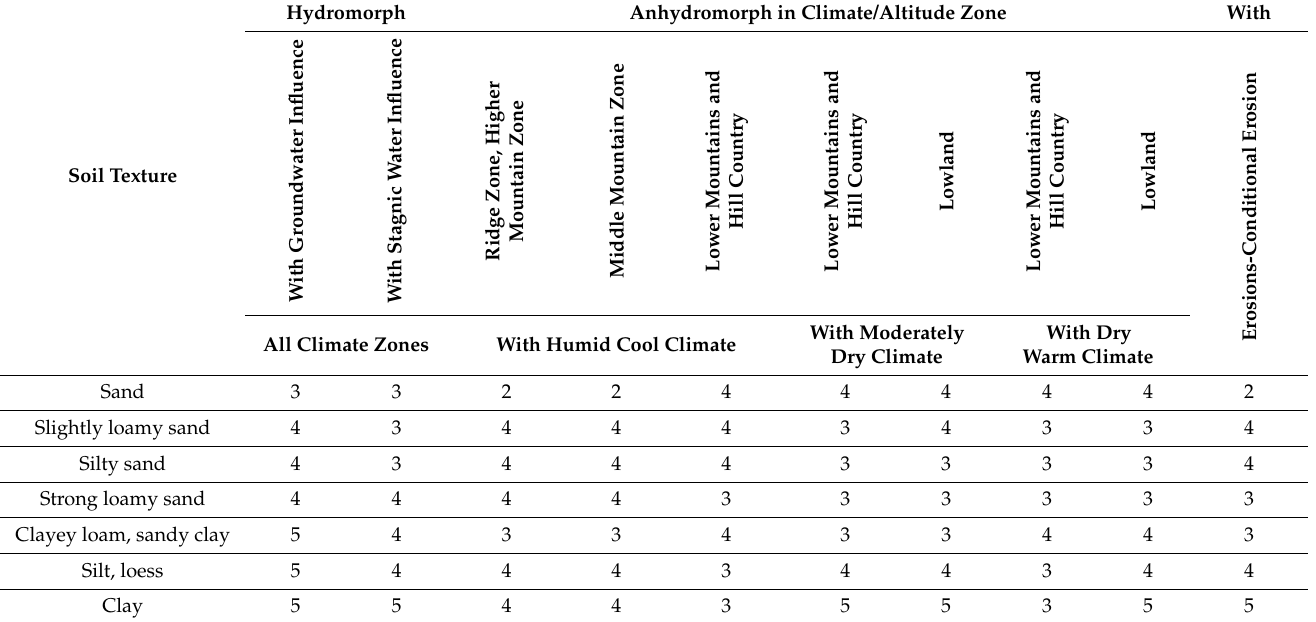
Table 8. Influence of climate/altitude levels and natural balance components on the formation of the plant-available humus level (after